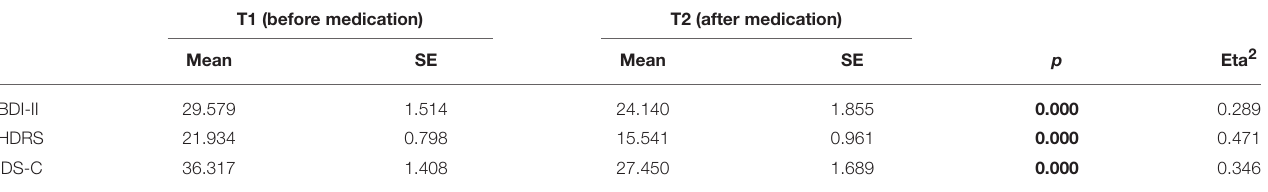
TABLE 3 | Change in Symptom severity of MDD patients before (T1) and after 2 weeks of antidepressant treatment (T2) as indexed by HDRS, BDI-II and IDS-C. T1 (before medication) T2 (after medication)